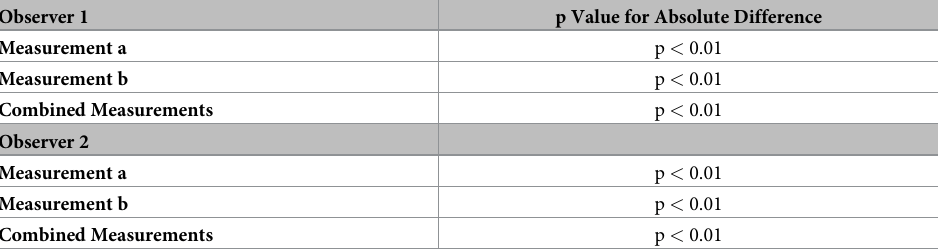
Table 5. Student t test for absolute differences for change in posterior offset with raTKA and conventional